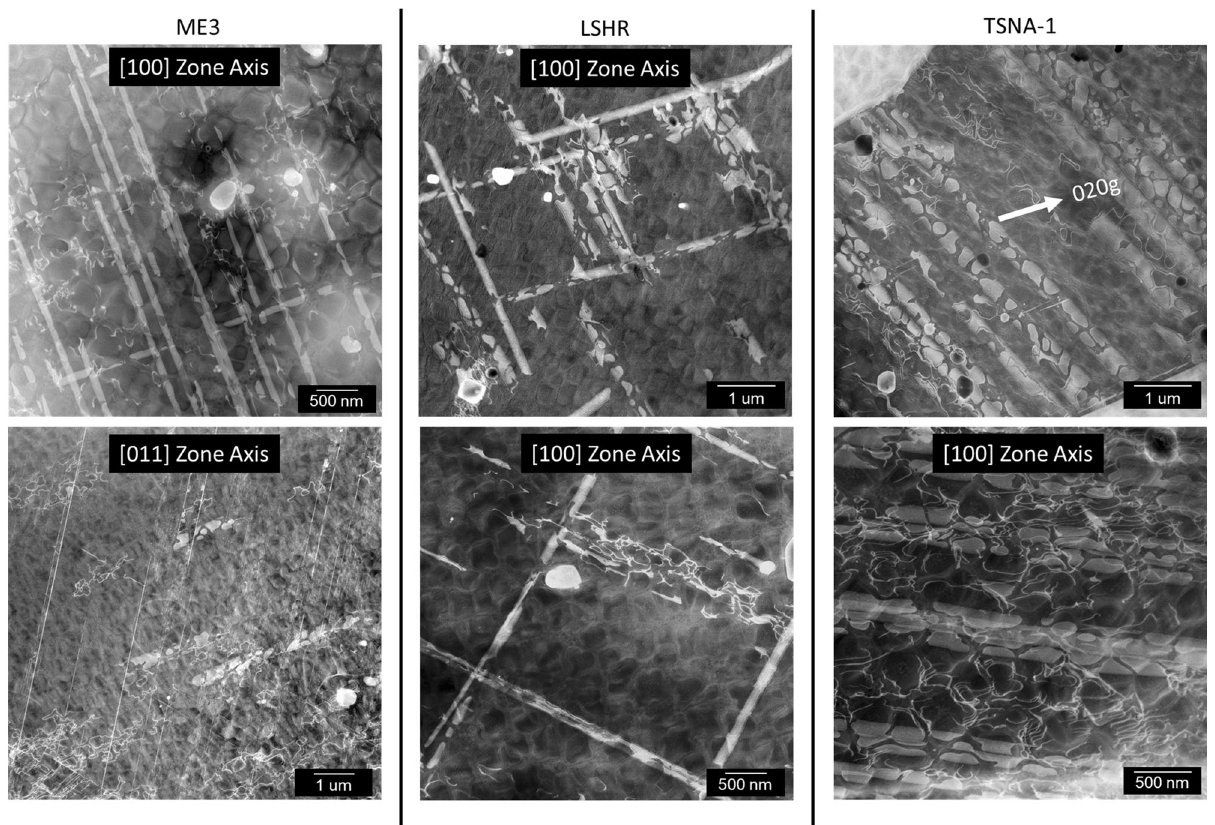
Fig. 3 STEM micrographs of creep deformation in disk superalloys. Representative STEM annular dark- fi eld micrographs of active deformation structures in ME3, LSHR, and